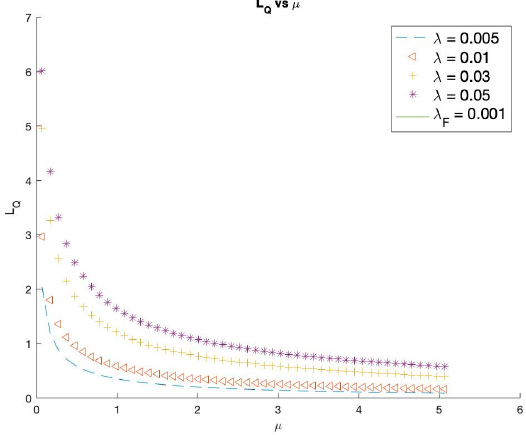
Figure 4. Average number of customers in the queue ( L Q ) vs rate of slots ( µ ).